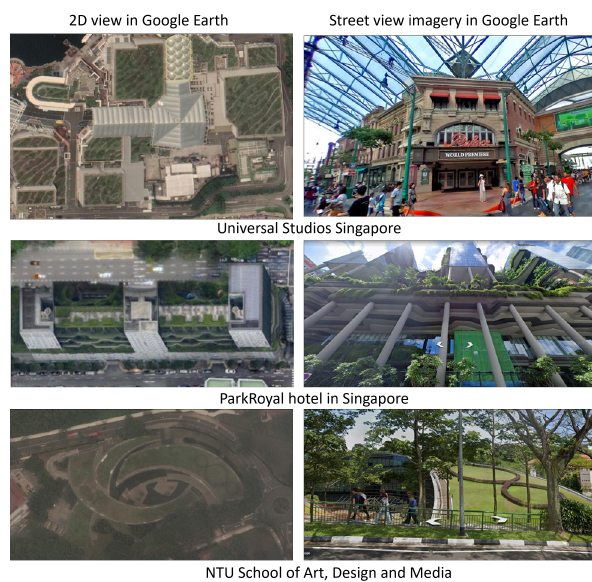
Figure 3. Examples of misleading green roofs: comparison between aerial view and street view imagery in Google Maps.